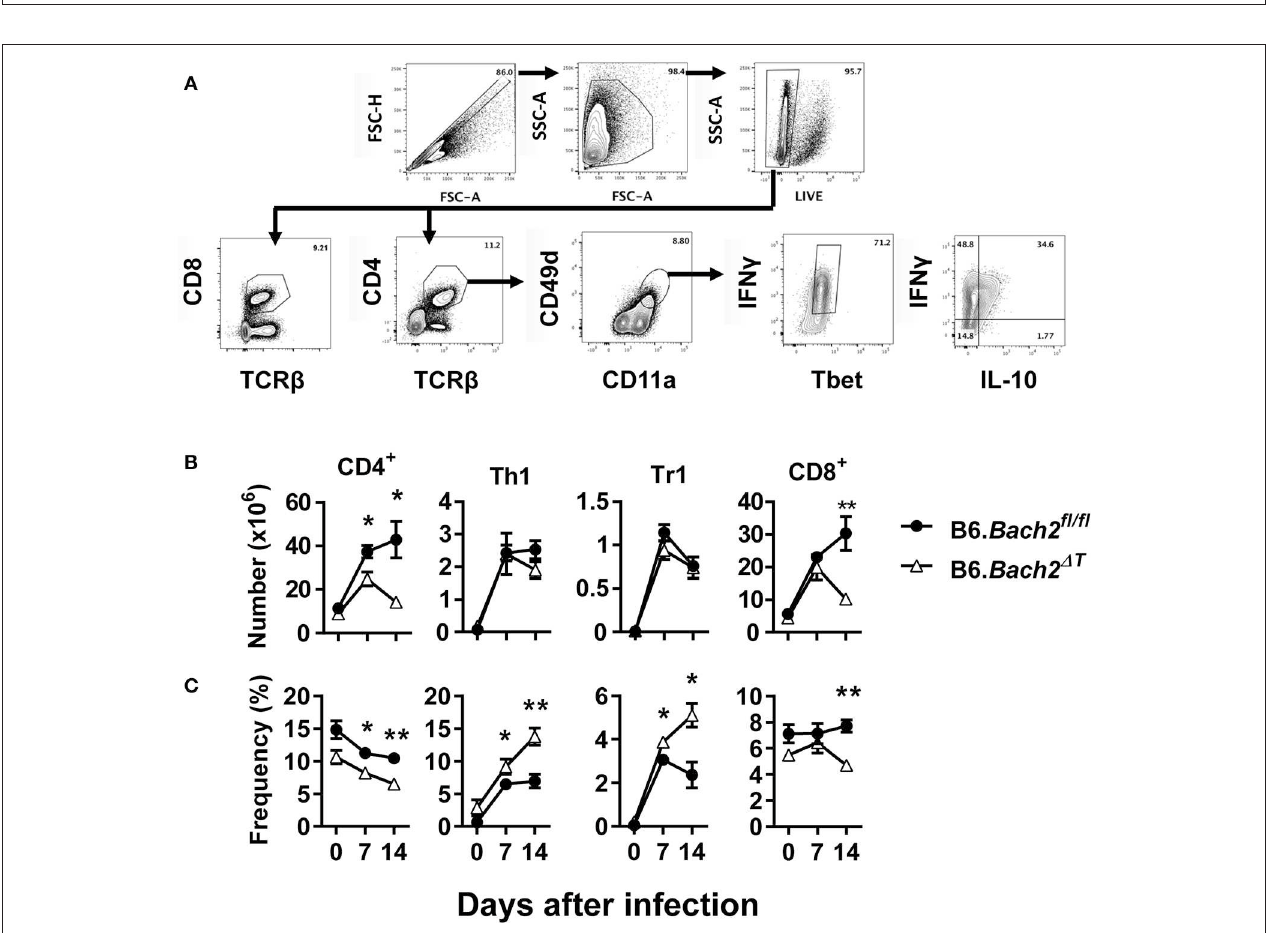
FIGURE 3 | T cell-specific BACH2 supports splenic CD4 + T cell expansion. (A) Gating strategy for CD4 + T, CD8 + T, antigen experienced (CD49d + CD11a + ), Th1 (IFN γ + , Tbet + ), and Tr1 (IFN γ + IL10 + ) cells in the spleens of B6. Bach2 ∆ T (open triangles) and B6. Bach2 fl / fl (closed circles) mice infected with P. chabaudi at 0, 7, and 14 days p.i., Numbers (B) and frequency (C) of CD4 + T, Th1, Tr1, and CD8 + T cells, as indicated, were measured by flow cytometry. n = 5–7 mice per time point, mean ± SEM, * P < 0.05, ** P < 0.01, significance assessed by Mann-Whitney